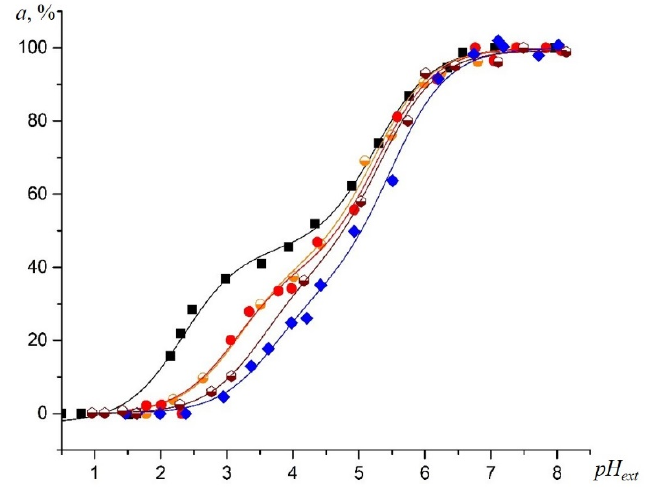
Figure 8. Experimental room-temperature EPR titration curves for the NR obtained by plotting iso-